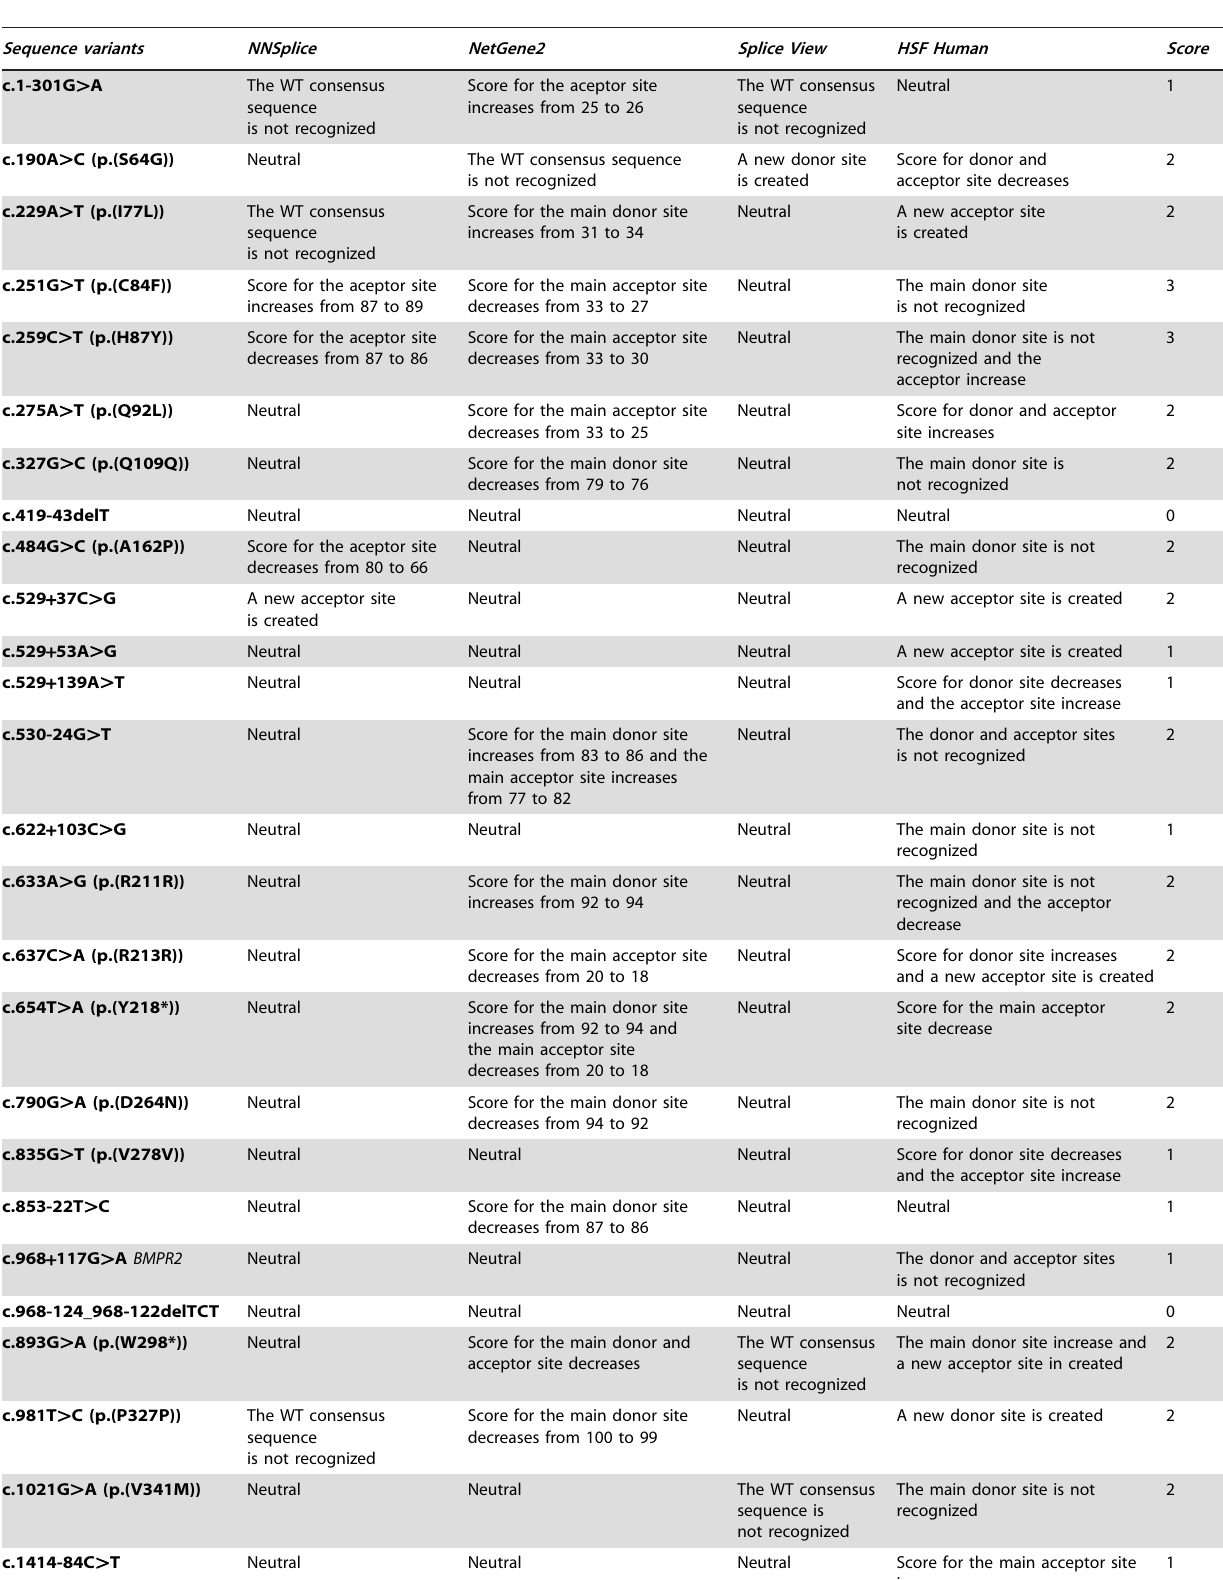
Table 3. Results from four different bioinformatic programs used to predict the effect on the splicing process in BMPR2 gene (NNSplice, NetGene2, Splice View and HSF